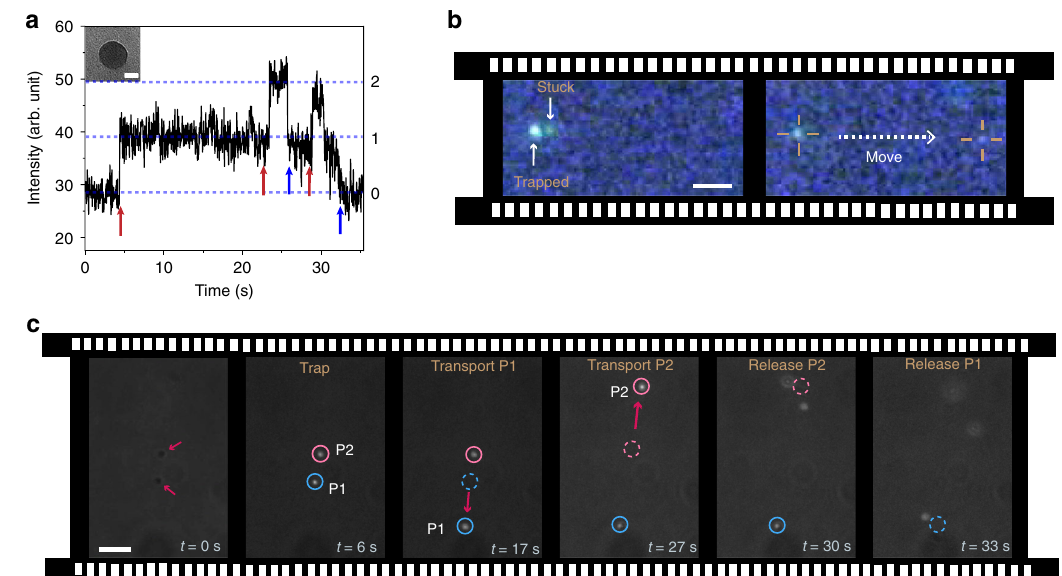
Fig. 6 Manipulation capabilities of ACTs. a Trapping and releasing of 40 nm (TEM image is shown in inset, scale bar 20 nm) fl uorescent PS particles by ACT (illumination intensity 32 mW μ m − 2 ). The red and blue arrows indicate individual nanoparticles enter and exit the trap respectively. See Supplementary Movie 7. b Manipulation of a collection of few 40 nm PS particles by moving the stage (scale bar 1 μ m). c Demonstration of parallel and independent control in nanomanipulation by two ACTs used for independently trapping, transporting and releasing (see Supplementary Movie 8) 300 nm fl uorescent magnetic particles (scale bar 3 μ